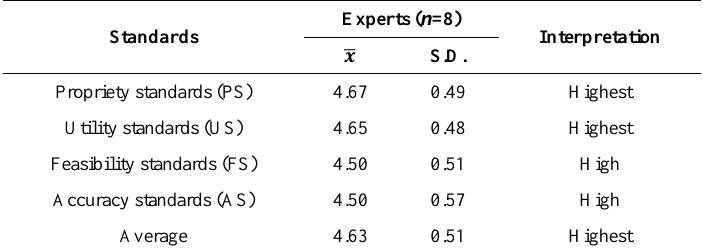
Table 1. The mean suitability level of the LIFD ATS Instruction